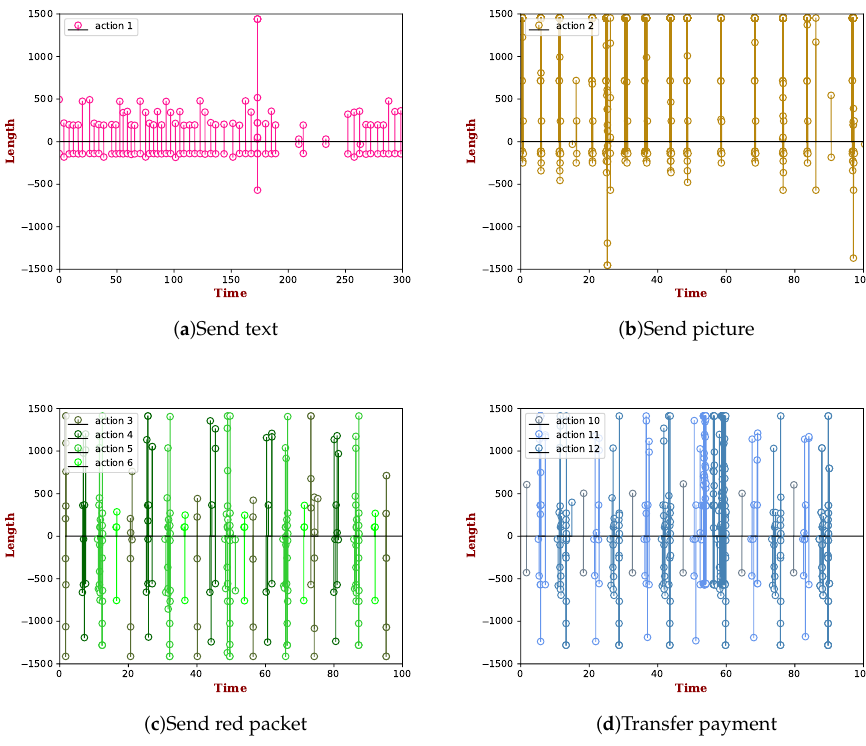
Figure 1. Packet time series distribution of user actions on the Alipay app.